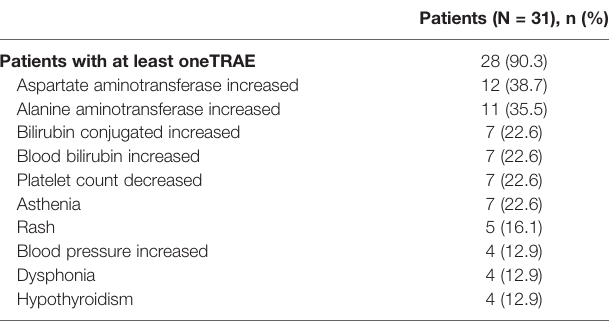
TABLE 4 | Treatment related AEs (TRAEs) with an incidence of more than 10%.